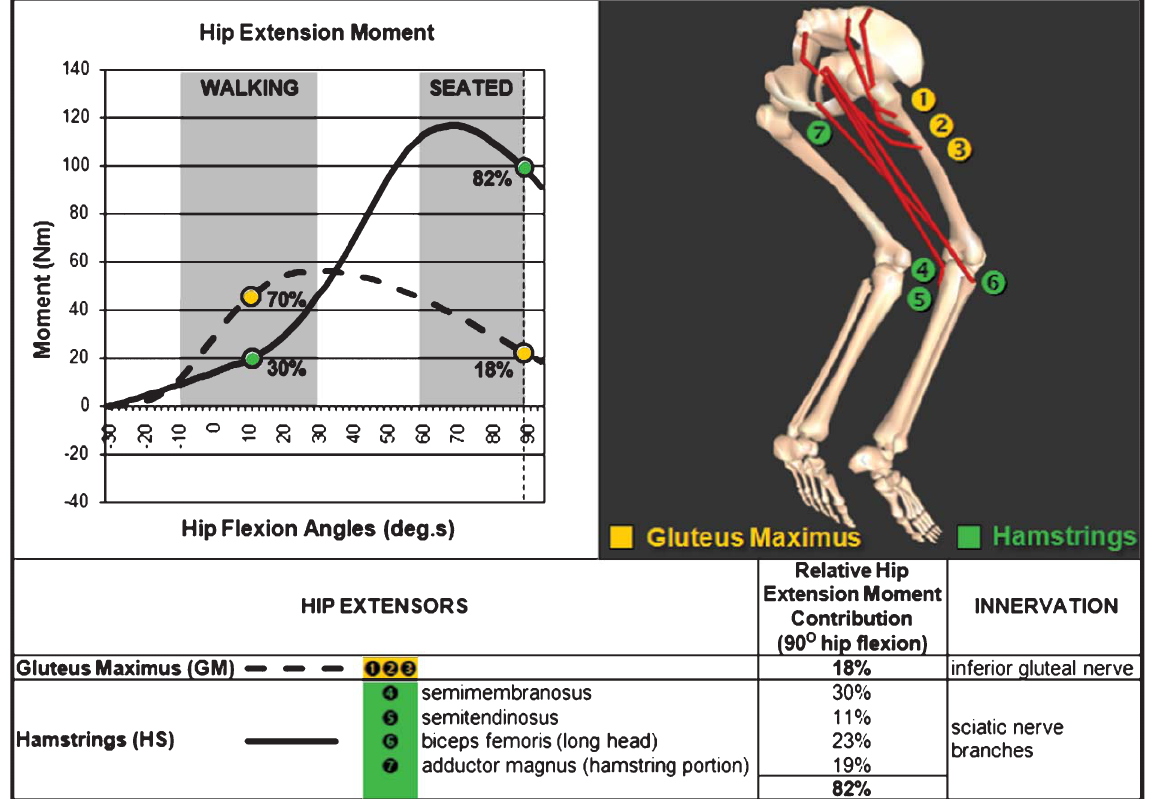
Fig. 2. Analysis of the relative contributions of the hip extensors to the total hip extension moment.